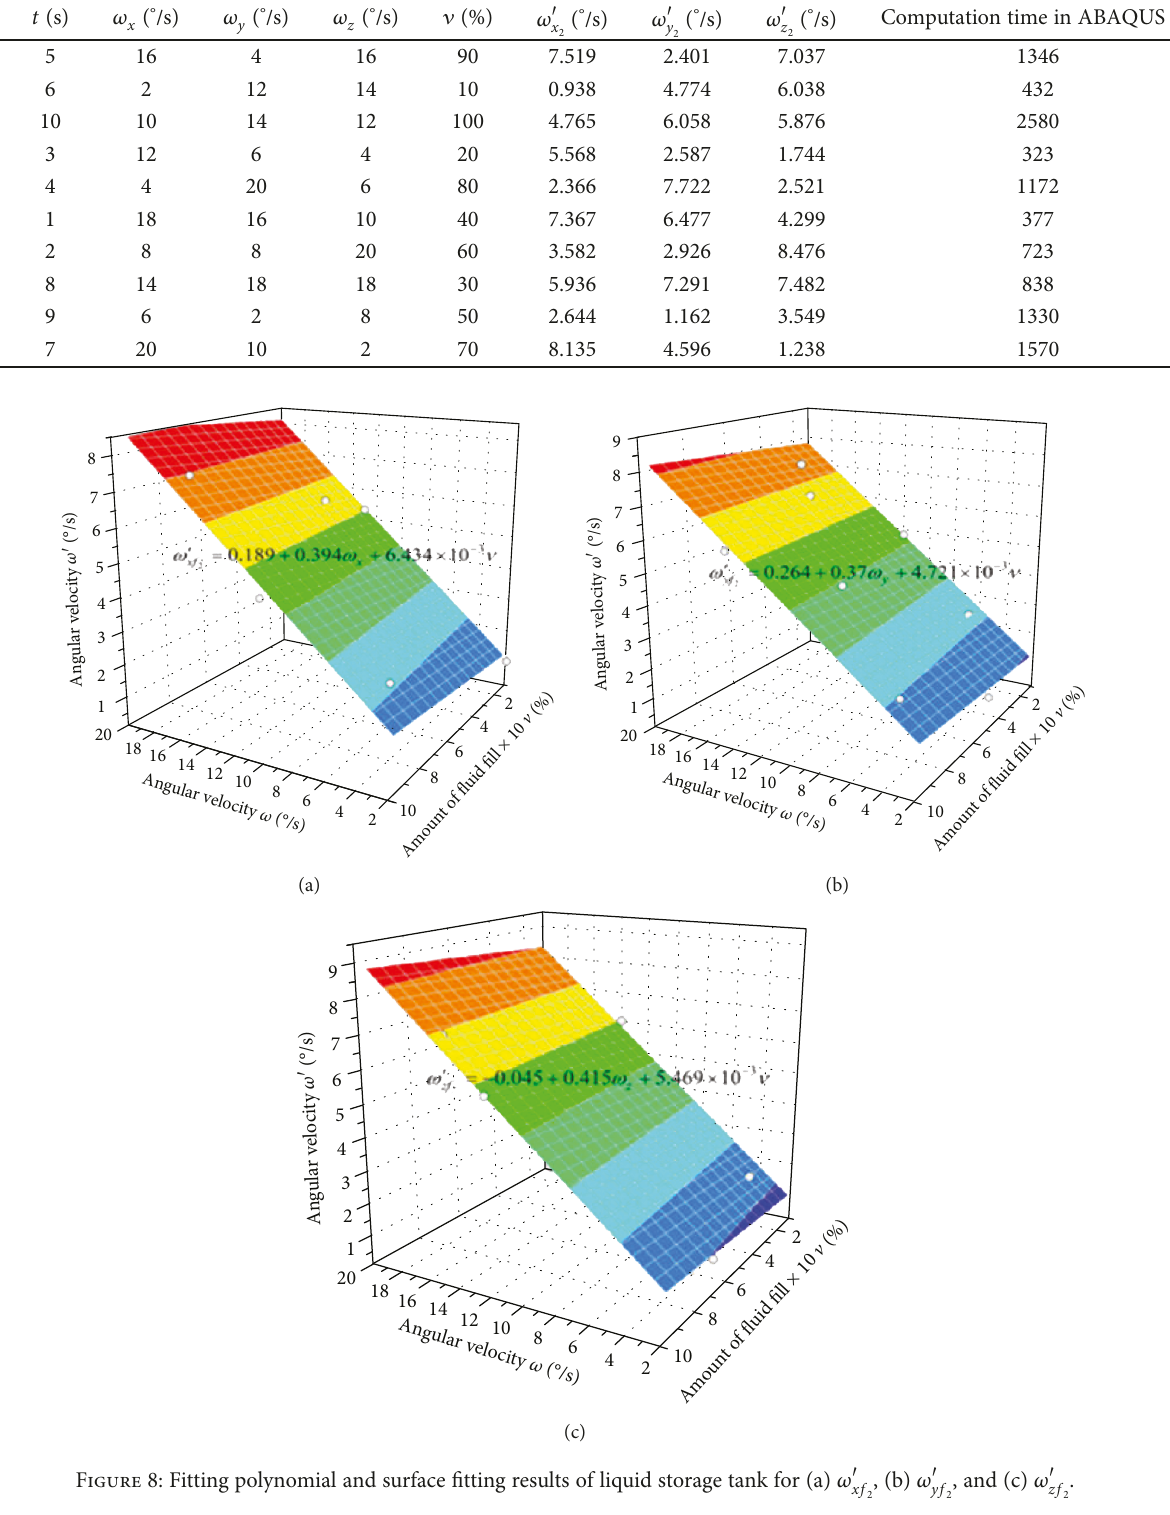
Figure 8: Fitting polynomial and surface fi tting results of liquid storage tank for (a) ω